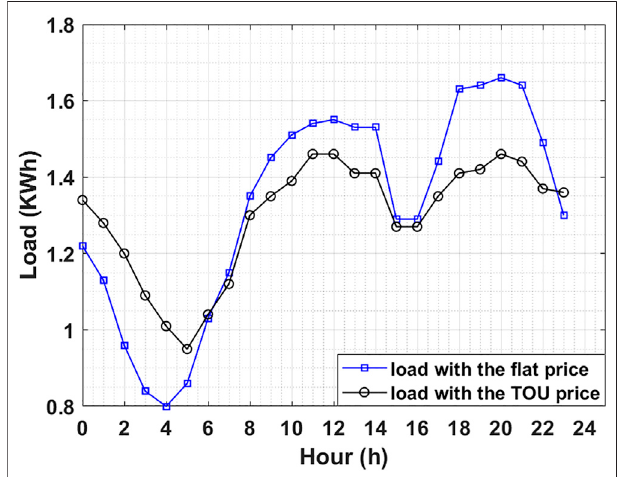
FIGURE 9 | Average load of the community between the fl at price and TOU